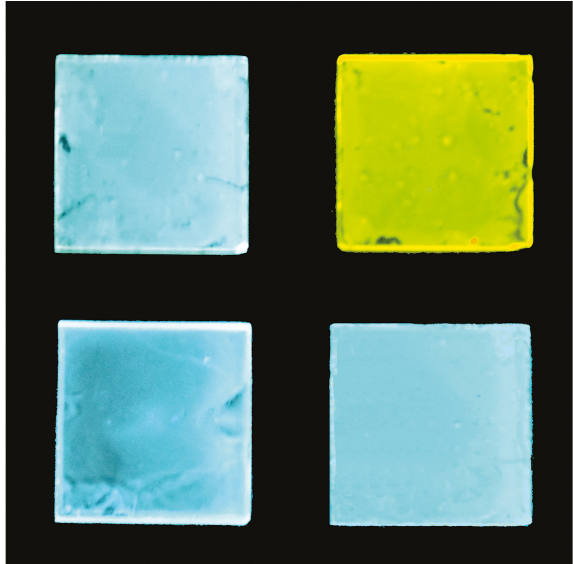
Figure 3: NPh2 and NPh5, respectively, neat solid samples (first line), and NPh2 and NPh5, respectively, PVK blends (second line), photographed under a UV lamp at